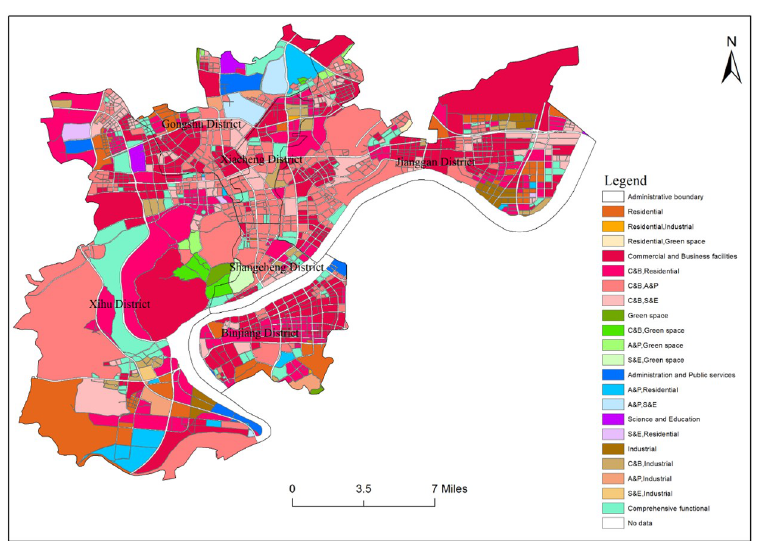
Fig 3. Recognition results of functional areas in the central city area of